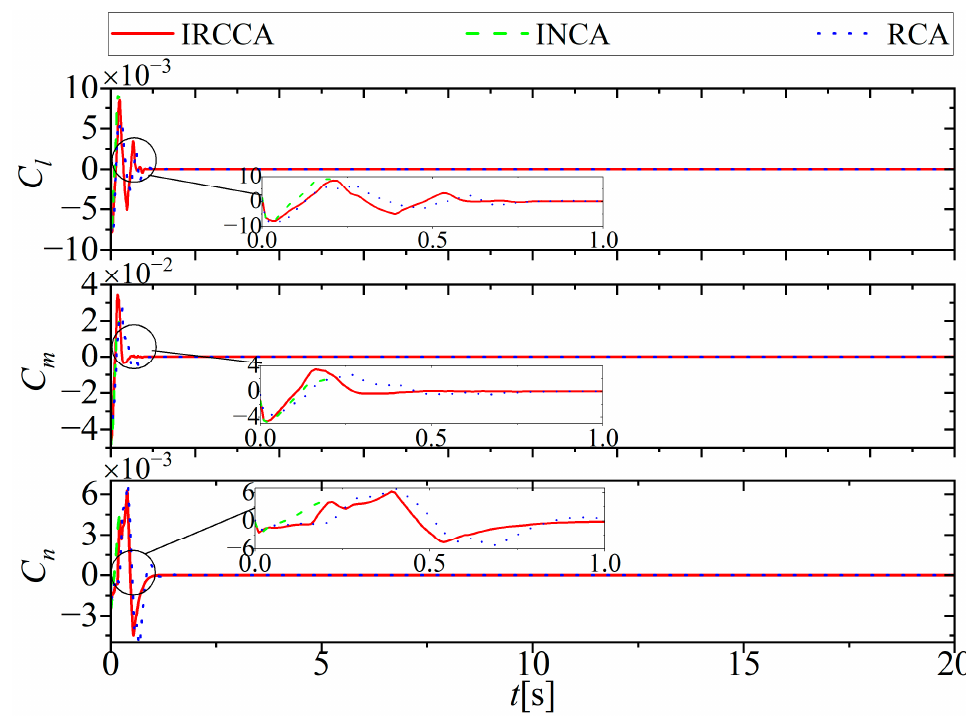
Figure 7. Time response of the moment coefficient with lock-in-place fault.